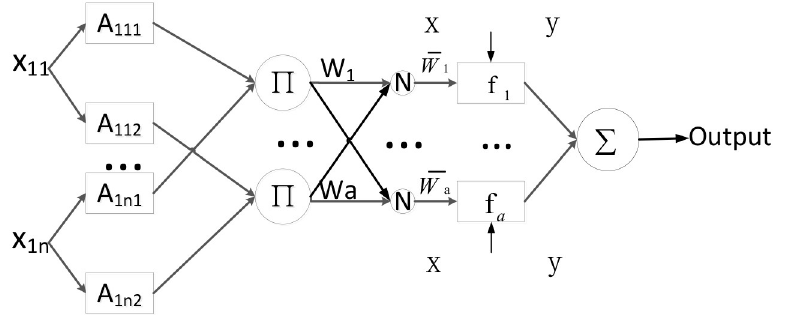
Fig 4. Architecture of